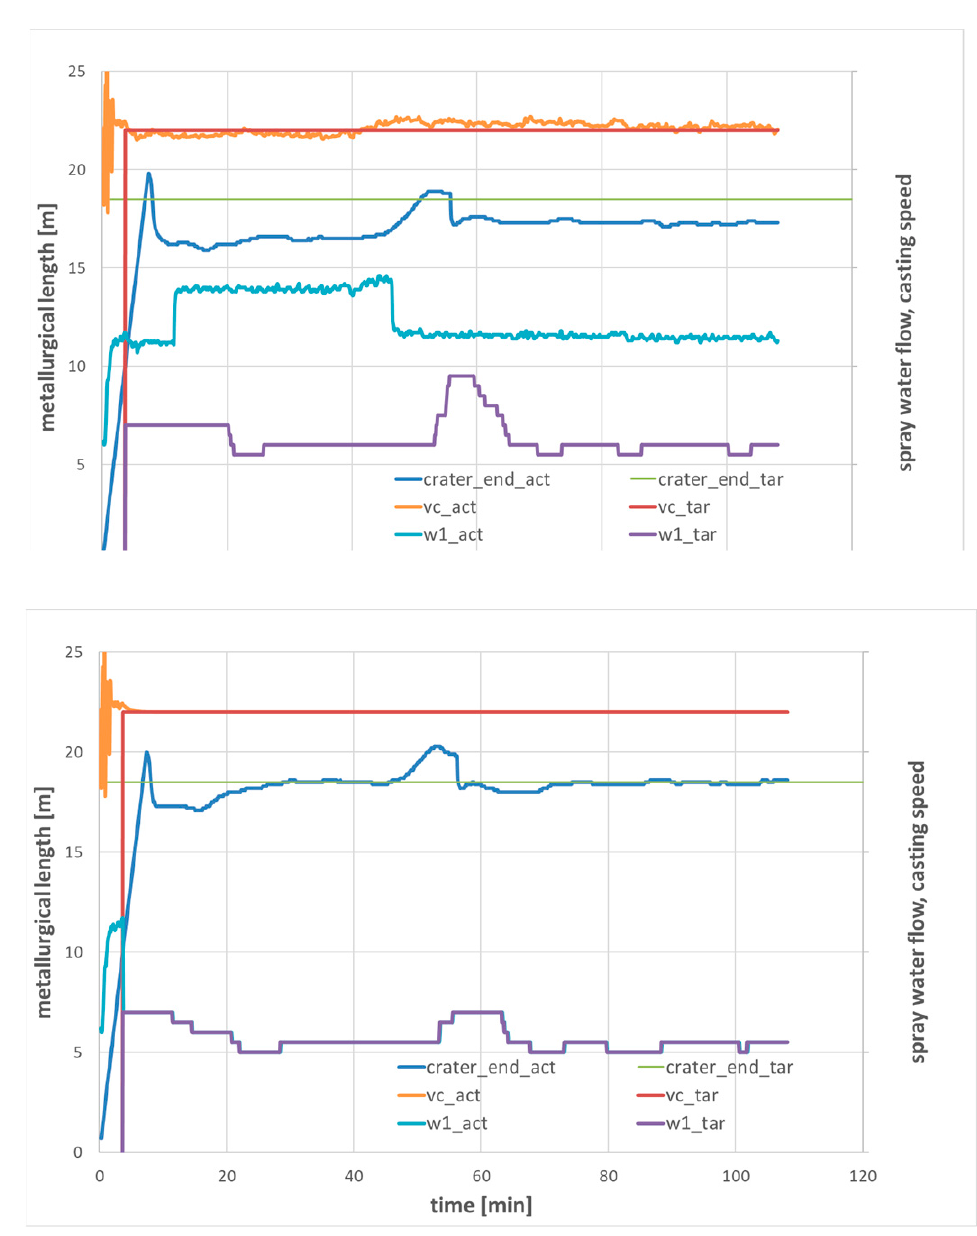
Figure 21. Evolution of actual and target casting speed, spray water flow and crater end position without ( top ) and with ( bottom ) application of target casting parameters for target crater end of 17.5 m at ESF billet caster.